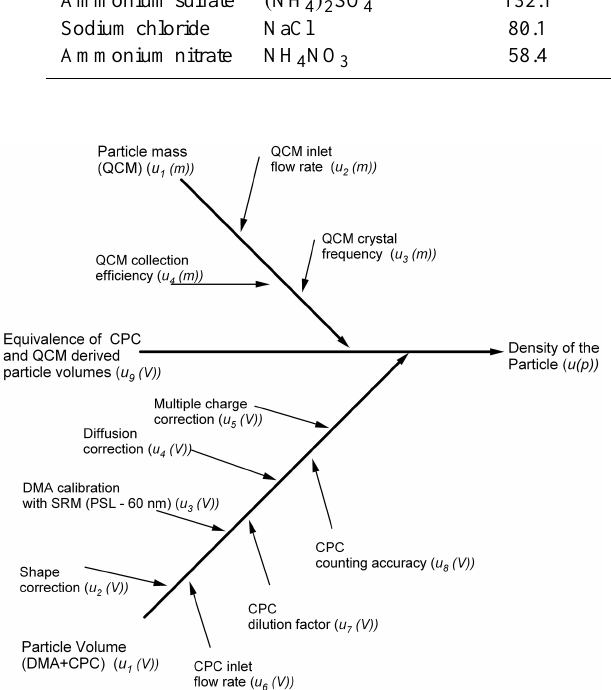
Figure 2. Cause-effective diagram of the uncertainty components considered in this study, constituting the entire uncertainty budget in the measurement of ρ eff using the SMPS–QCM